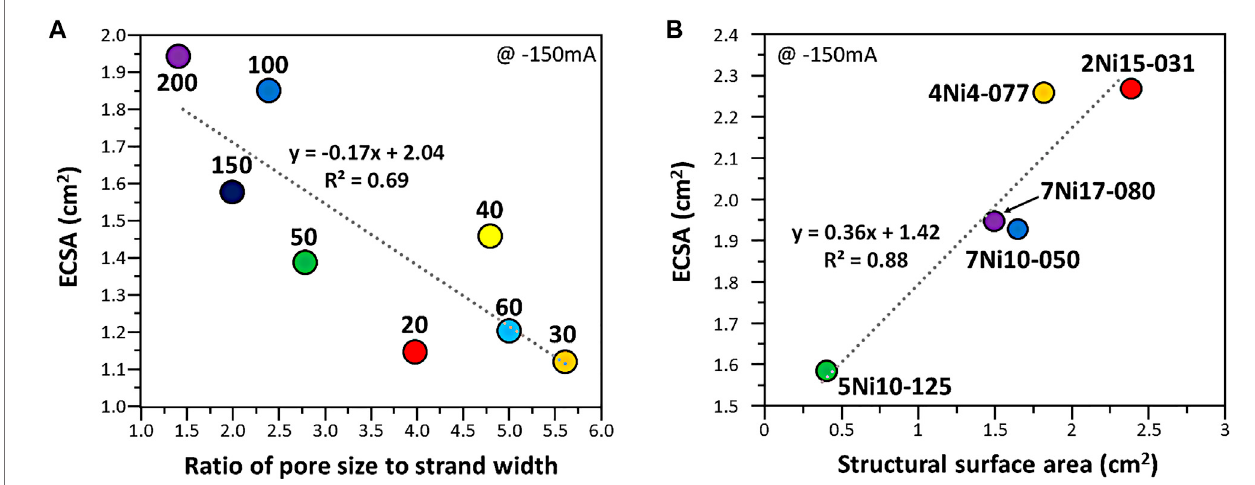
FIGURE 4 | Electrochemically active surface area values as a function of (A) ratio of pore width to strand width of woven mesh and (B) structural surface area of expanded mesh. The dotted line represents the linear regression plot obtained from the data.